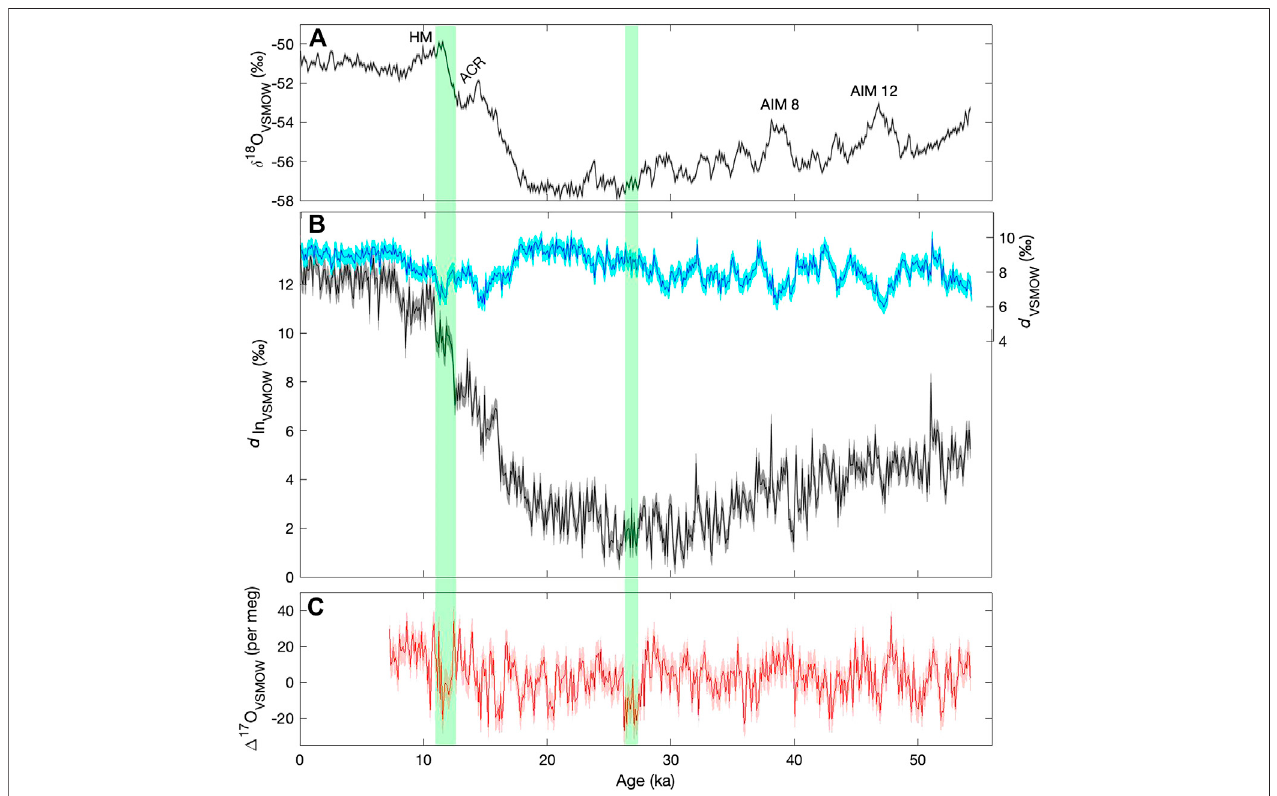
FIGURE9| WaterisotopetimeseriesfromtheSouthPoleicecore,shownataresolutionof100 years (A) δ 18 O (B) , d (lightblue)and d ln (darkblue) (C) , Δ 17 O.Shading shows2standarddeviationanalyticaluncertaintiesdeterminedfromreplicatemeasurements.Labelsinthetop panelshowtheHolocenemaximum (HM),theAntarcticCold Reversal (ACR), and the two most prominent Antarctic Isotope Maximum (AIM) events. Green vertical bars highlight features in the Δ 17 O record referred to in the text.